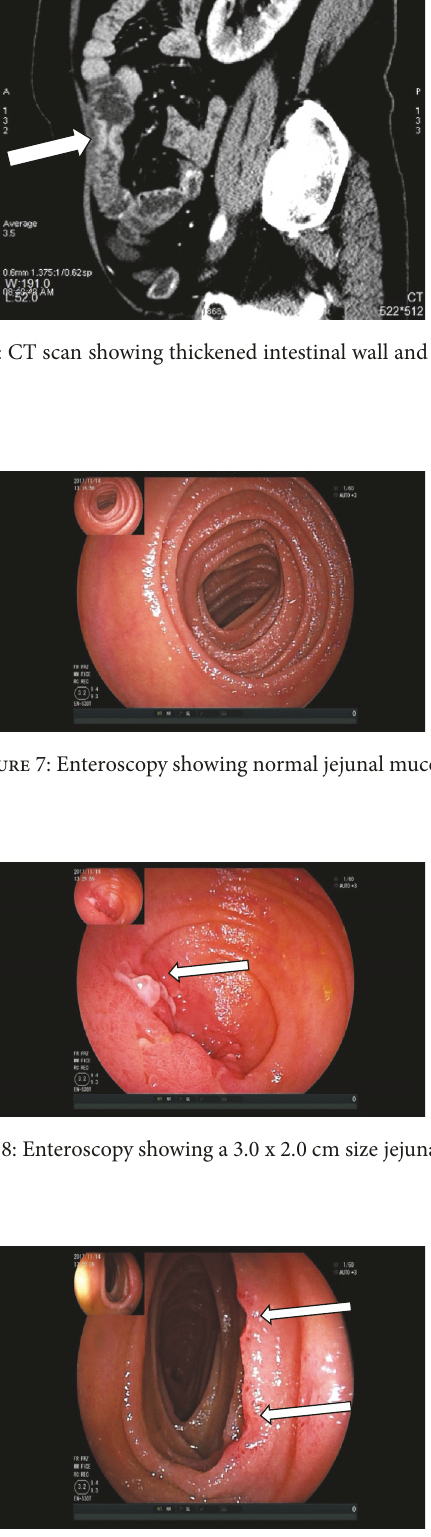
Figure 9: Enteroscopy showing several jejunal